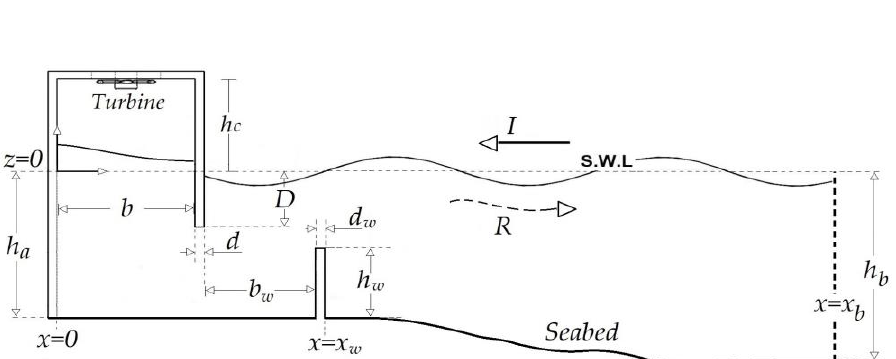
Figure 7. Definition of Alternative Oscillating Water Column (U-OWC) dimensions in variable